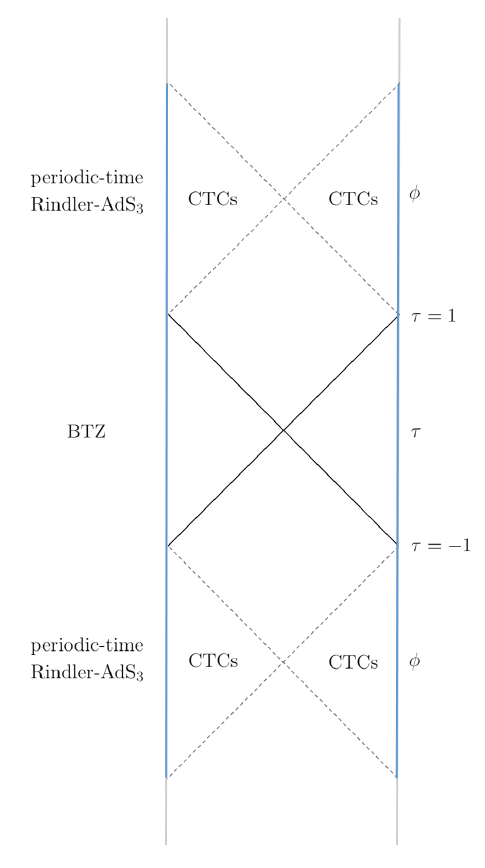
Figure 5. Sketch of the bulk for α < 1 / 2 states (not a proper Penrose diagram, since it mixes sections of constant φ for the BTZ portion, and of constant t for the Rindler-AdS 3 portions, where the periodicity of time φ is not represented). Dashed diagonal lines represent chronology horizons, while the diagonal solid lines indicate the BTZ black hole horizons. The blue boundary lines represent two identical, complete Misner-AdS 2 spacetimes. Since it is possible to cross from one to the other, the bulk is a traversable wormhole. It is expected that bulk quantum effects will render the chronology horizons singular, and close up the